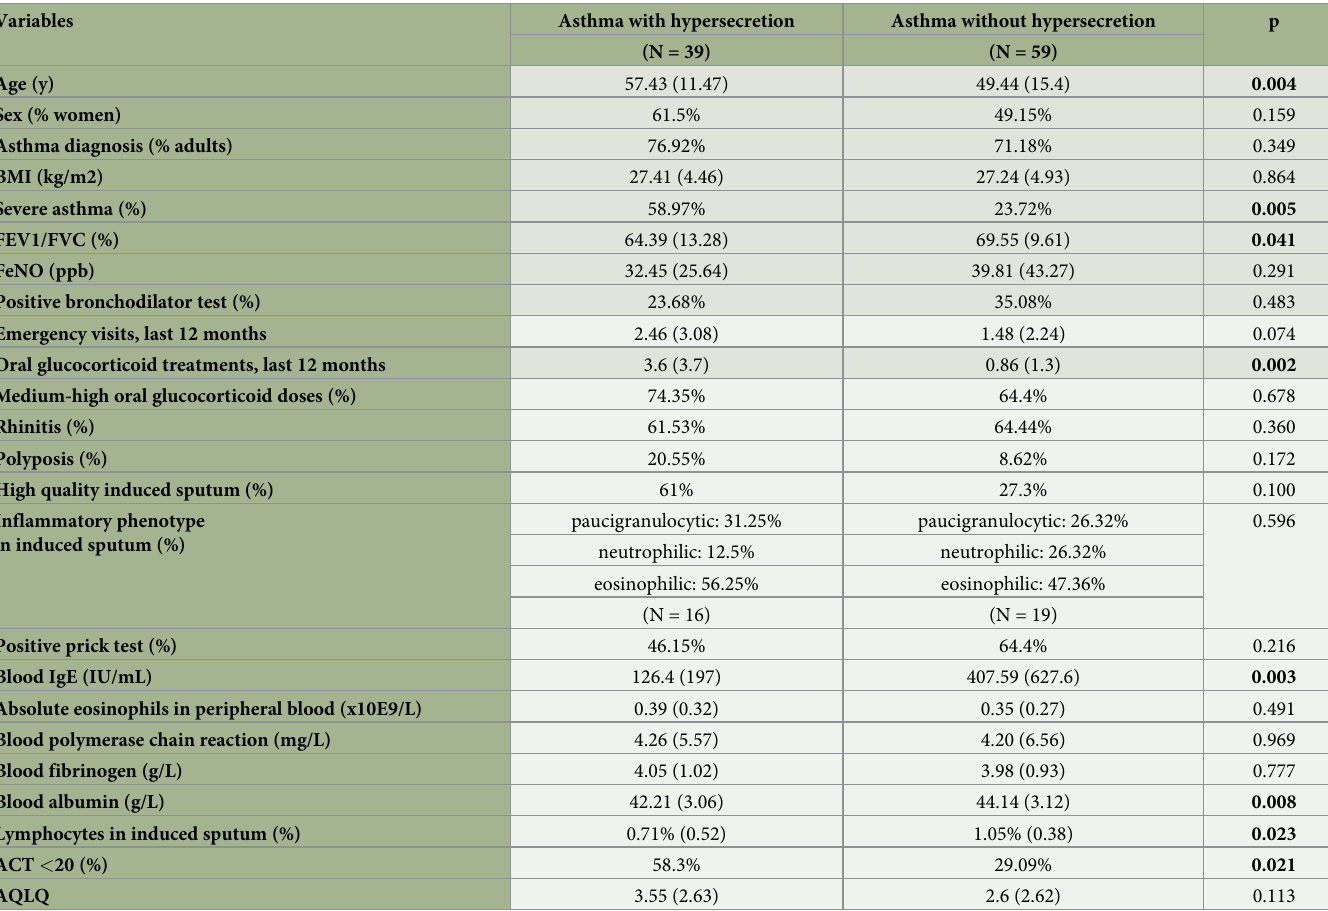
Table 4. Demographic, clinical and functional characteristics of asthma with and without airway mucus